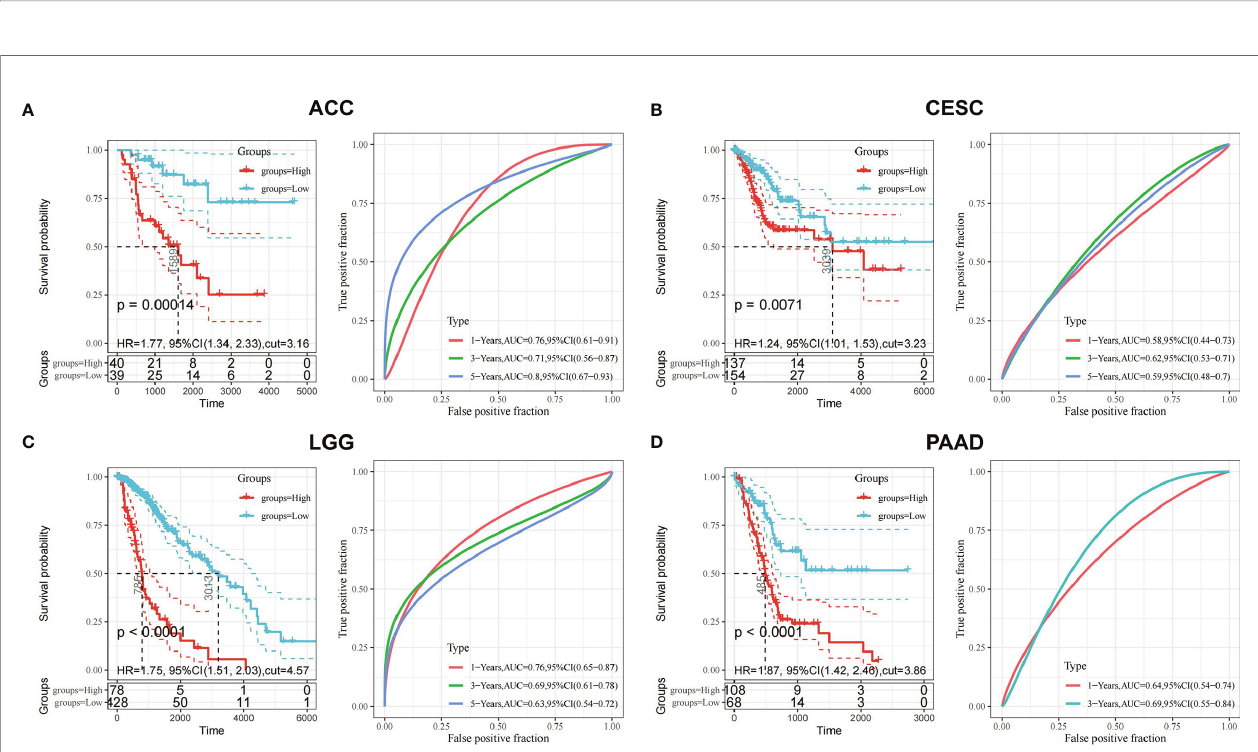
FIGURE 5 | Prognostic validation of T. hemsleyanum potential target protein CDK6 in four tumors. (A) Kaplan – Meier survival analysis of CDK6 in ACC and ROC curve. (B) CESC. (C) LGG. (D) PAAD.